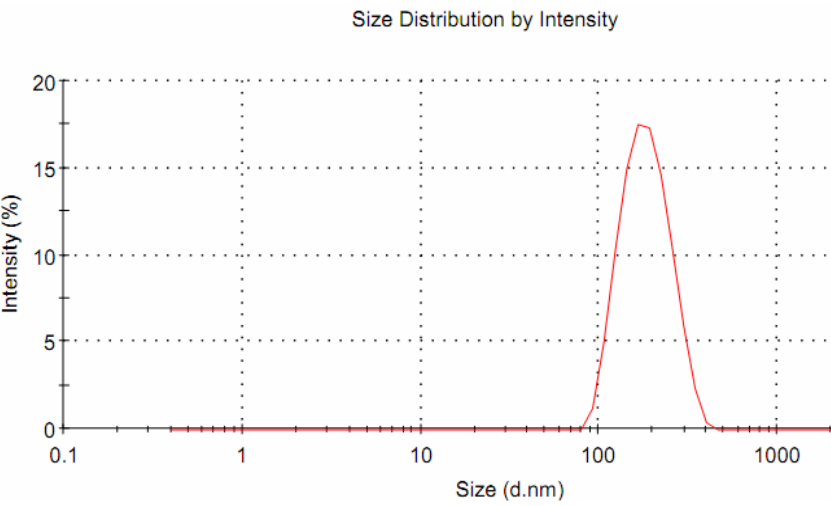
Figure 4. Size distribution of CA-CH-H